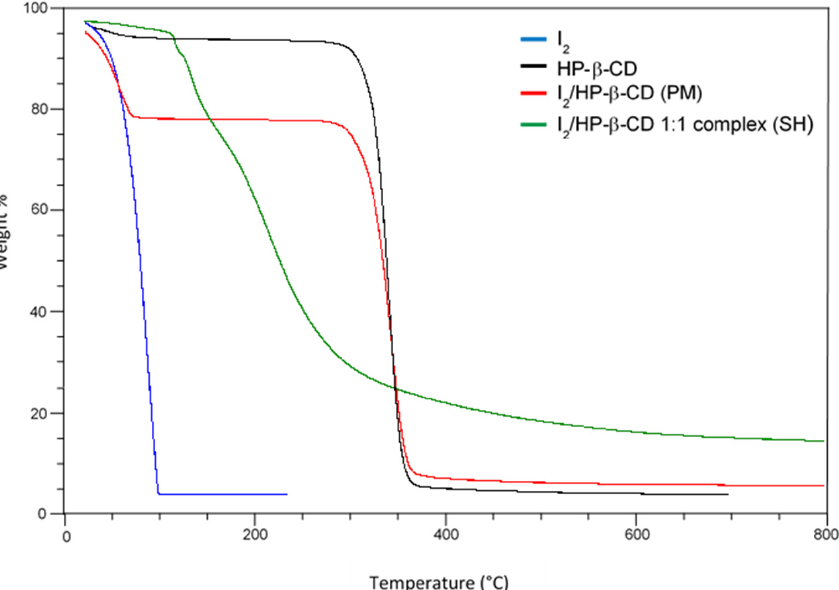
Figure 1. Thermogravimetric (TG) curves of iodine and HP- β -CD as pure components, their 1:1 physical mixture (PM), and 1:1 complex prepared by SH